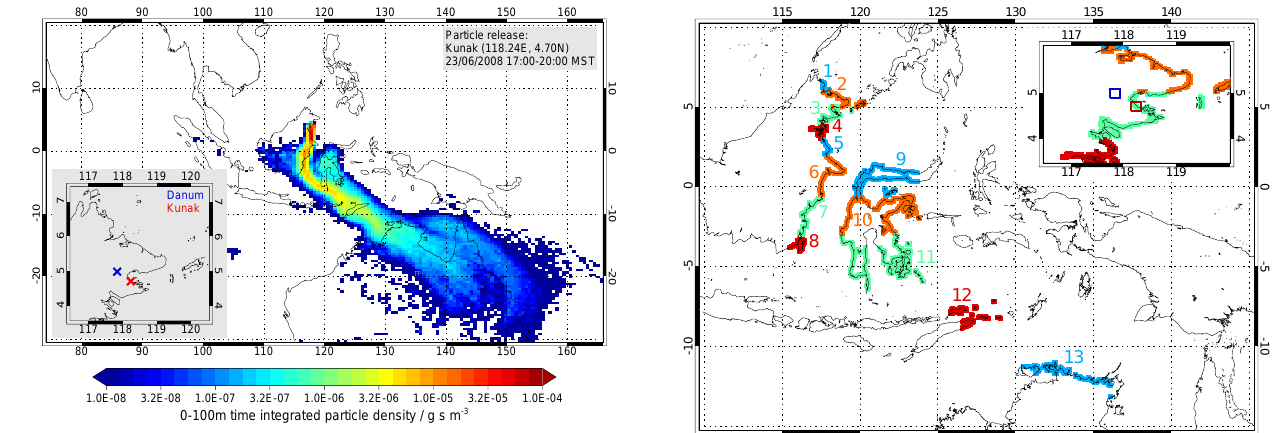
each particle has a specified e-folding lifetime of 15 days and the starting value. So, this experiment mimics the distribu- tion of a coastally-emitted tracer, like bromoform (although bromoform also has an open ocean source). The emitting coastal boxes have dimensions 0.1 ◦ × 0.1 ◦ and the emissions per unit area are constant. Note that the different regions in Fig. 5 do not have the same areas. Summing the individ- ual tracers at any location gives the total tracer concentra- tion there, assuming that all the tracer originates from our emitting regions, i.e., there is no “background” arising from longer-range transport. Time series of the total tracer dis- tributions from this experiment for Kunak and Danum are shown in Fig. 6, where the vertical axis shows normalised the conversion to mixing ratios). Results are for the low- est 100 m of squares of size 0.2 ◦ centred on the two loca- emissions while Danum does not. The results in Fig. 6 show some similarities to Fig. 1. First, the concentrations at Danum (mean = 1 . 31 ppt) are usually (71% of the time) less than at Kunak (mean = 1 . 72 ppt), sometimes by a